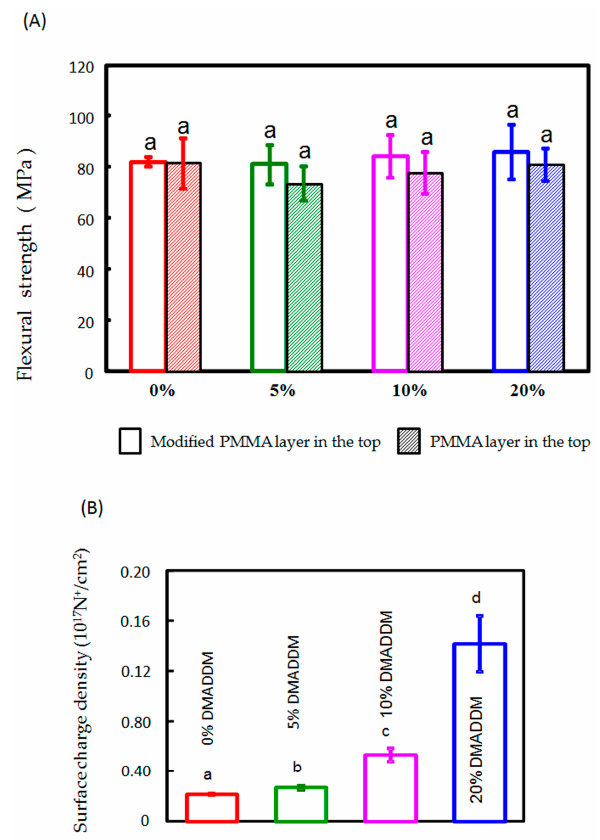
Figure 4. Flexural strength and surface charge density of double-decked acrylic resin. ( A ) Flexural strength. In each plot, the same letter indicates that there was no significant difference between the groups ( p > 0.05); ( B ) Surface charge density. In each plot, dissimilar letters indicate values that are significantly different from each other ( p < 0.05).